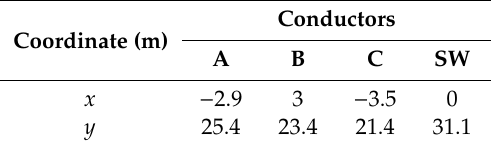
Table 1. Phase and shield wire conductor coordinates.